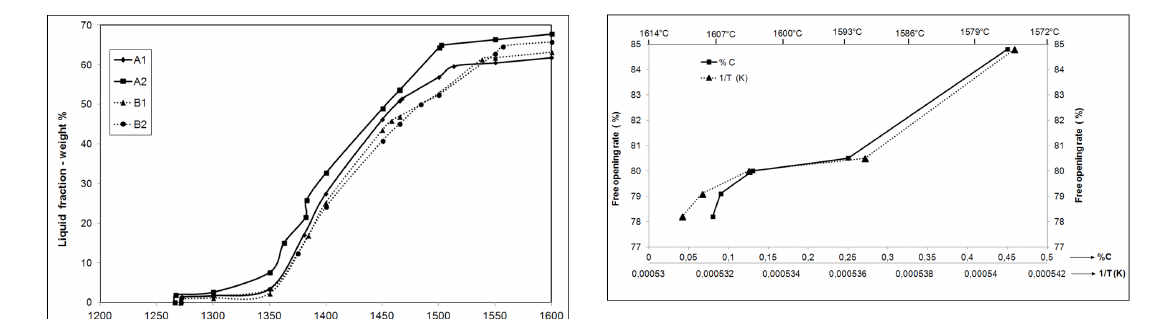
Figure III. FactSage simulation. Liquid fraction as a function of temperature for A1, A2, B1 and B2.